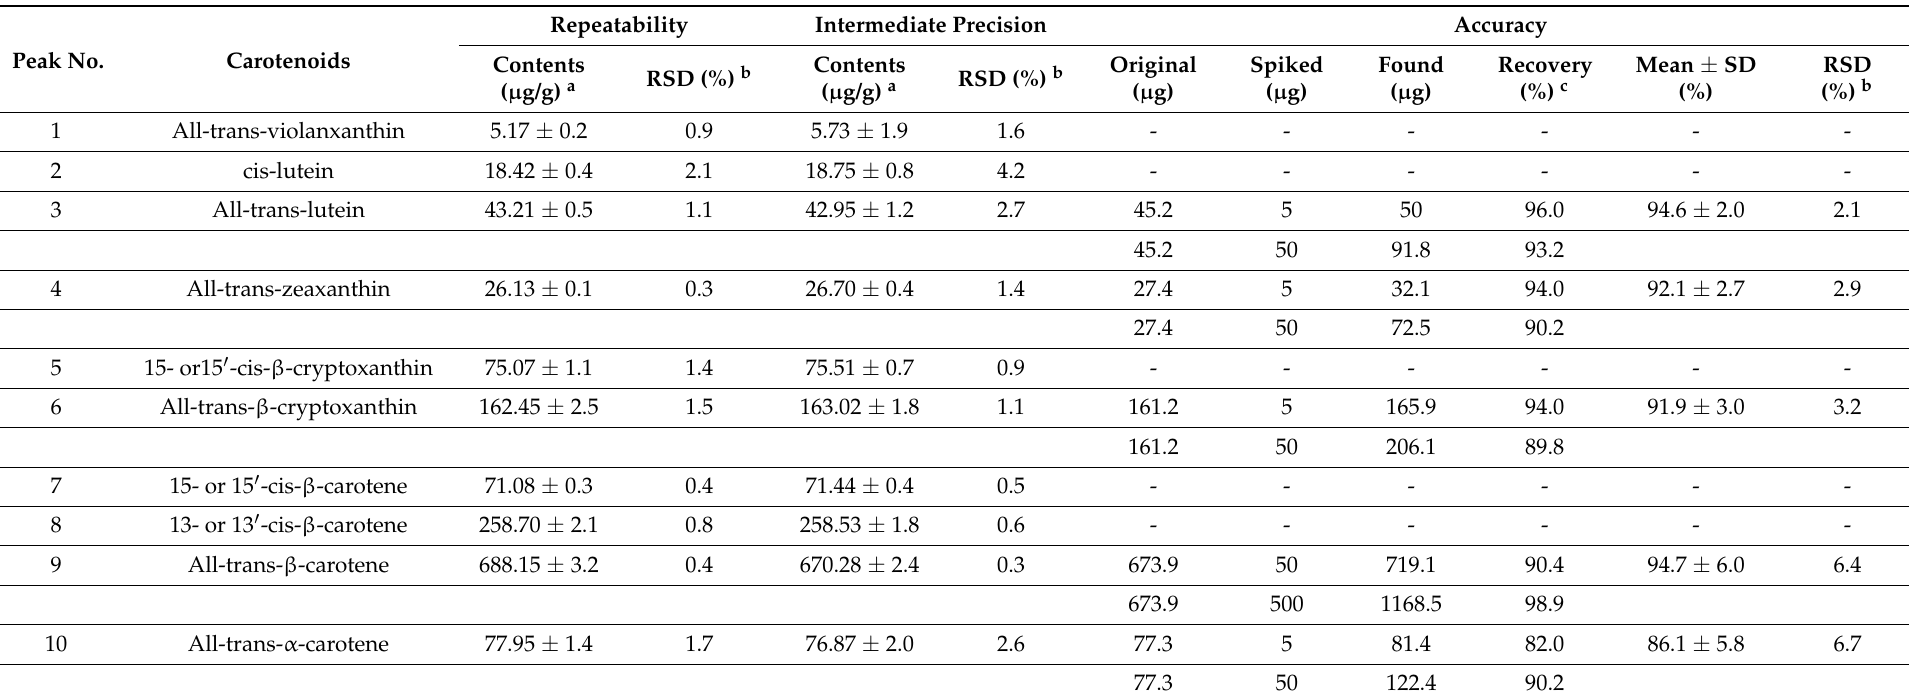
Table 2. Quality control data of carotenoids in sweet potato peel (TNG 66) by HPLC-DAD.